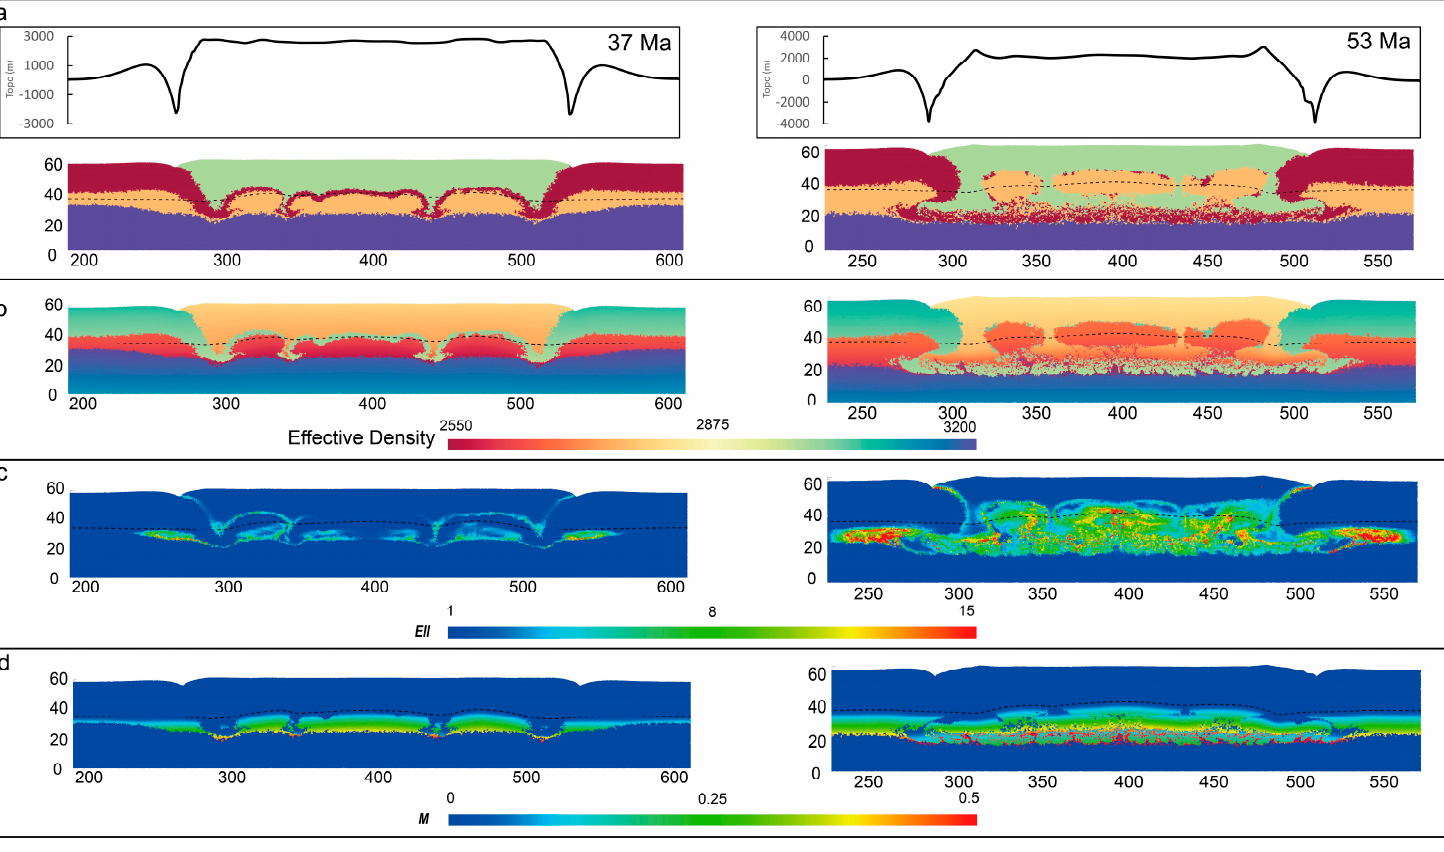
Figure 11. Model400, the width of sediment is set to 400 km. The solidus temperature of the lower crust is shown in dashed line. ( a ) At 37 Ma, buoyant lower crustal rocks start to form three crustal-scale folds and break through the competent mafic layer beneath the sediment. Moderate-high pressure volcano-sedimentary rocks are preserved in two-fold hinges. At 53 Ma, partially molten lower crustal rocks ascend into the sediment and form three diapirs. ( b ) Effective density is calculated by Equations (5) and (6). ( c ) The accumulation ( EII ) of the second invariant of the strain rate ( ε II , s − 1 ) is employed to identify shear zones over time (calculated by EII = ∑ t ε II · ∆ t ). ( d ) Melt fraction is obtained by Equations (2) and (3). 0